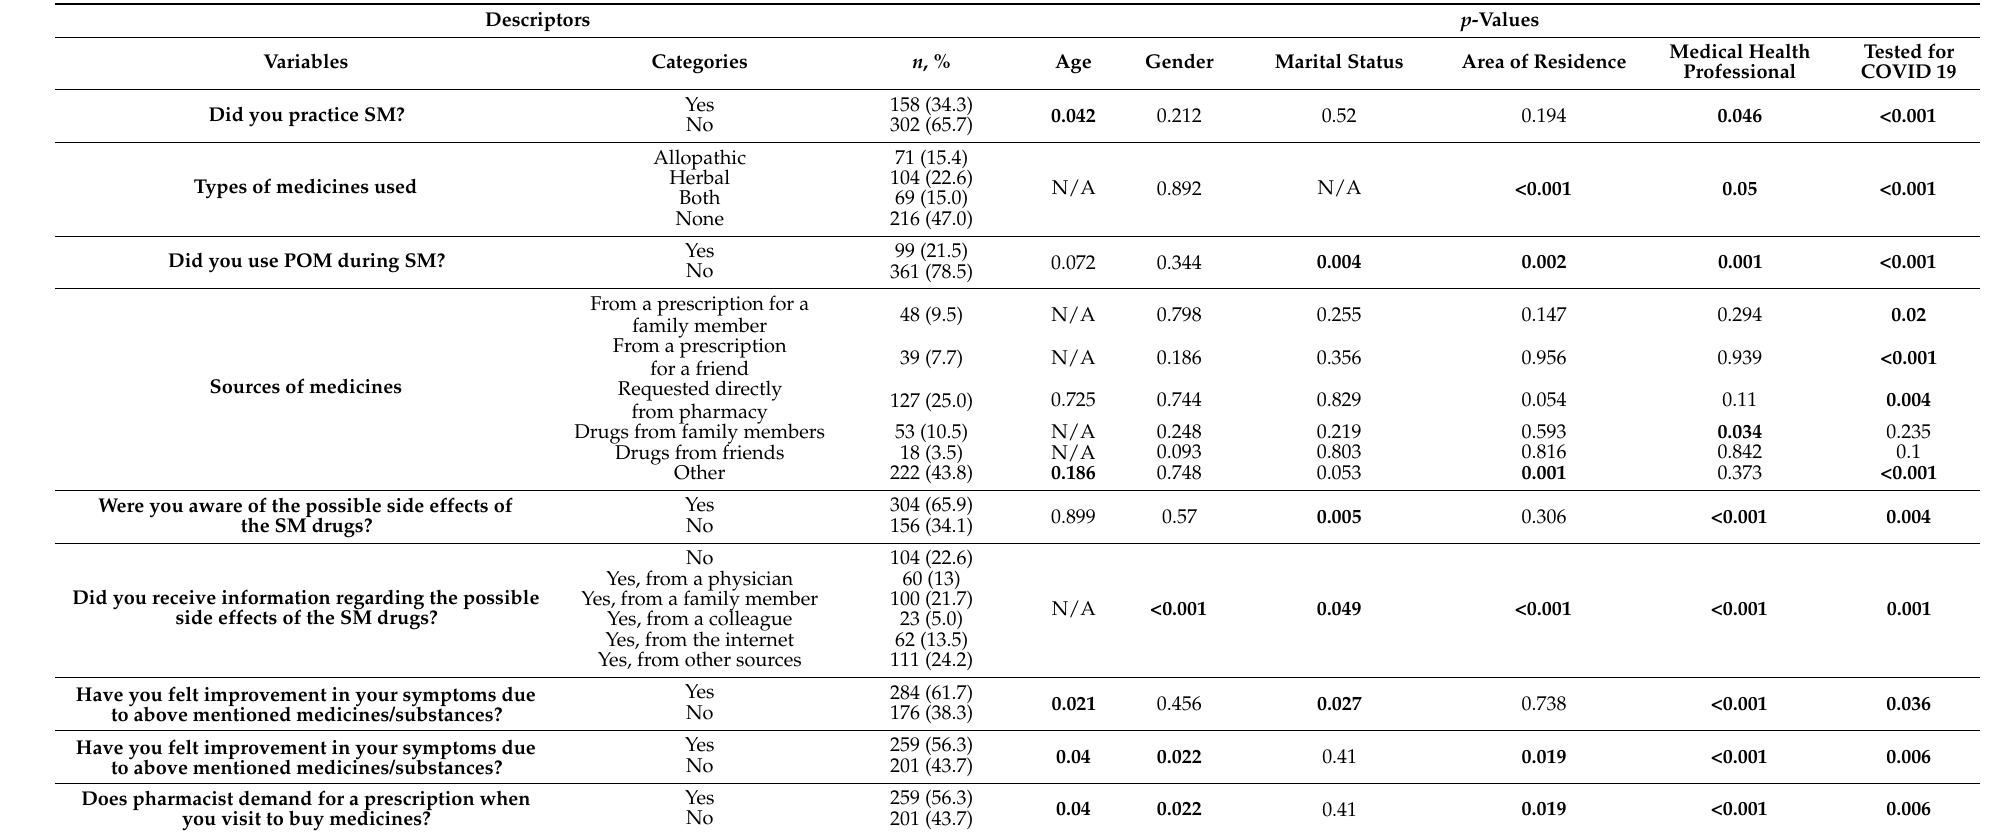
Table 2. Characteristics of SM during the COVID-19